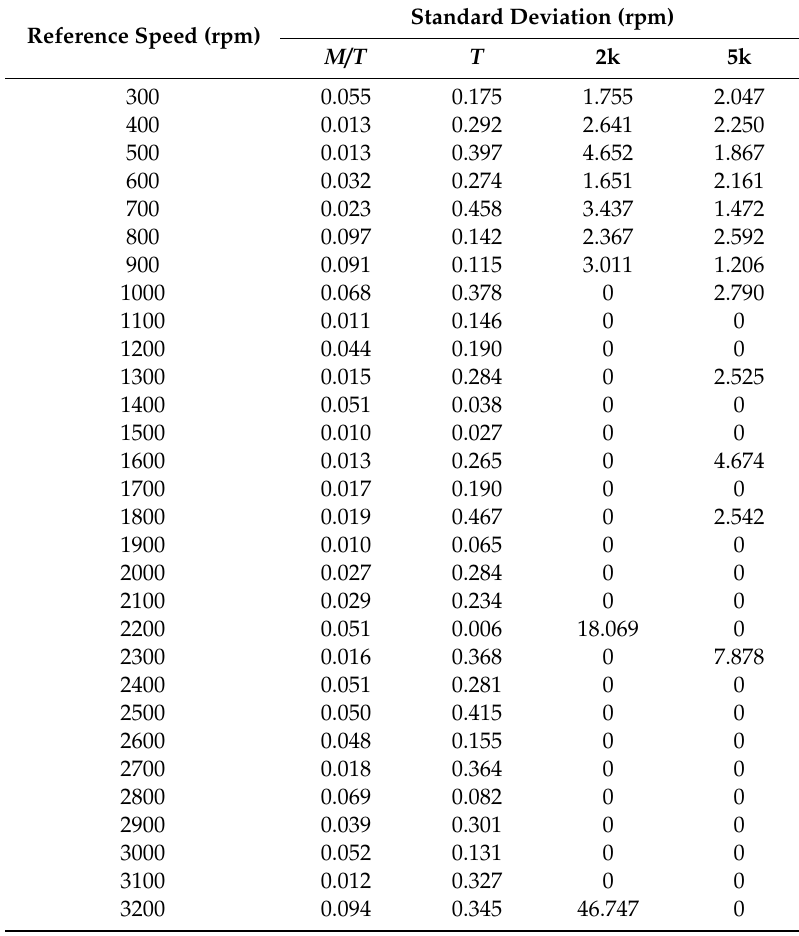
Table 2. The standard deviations of the measurement